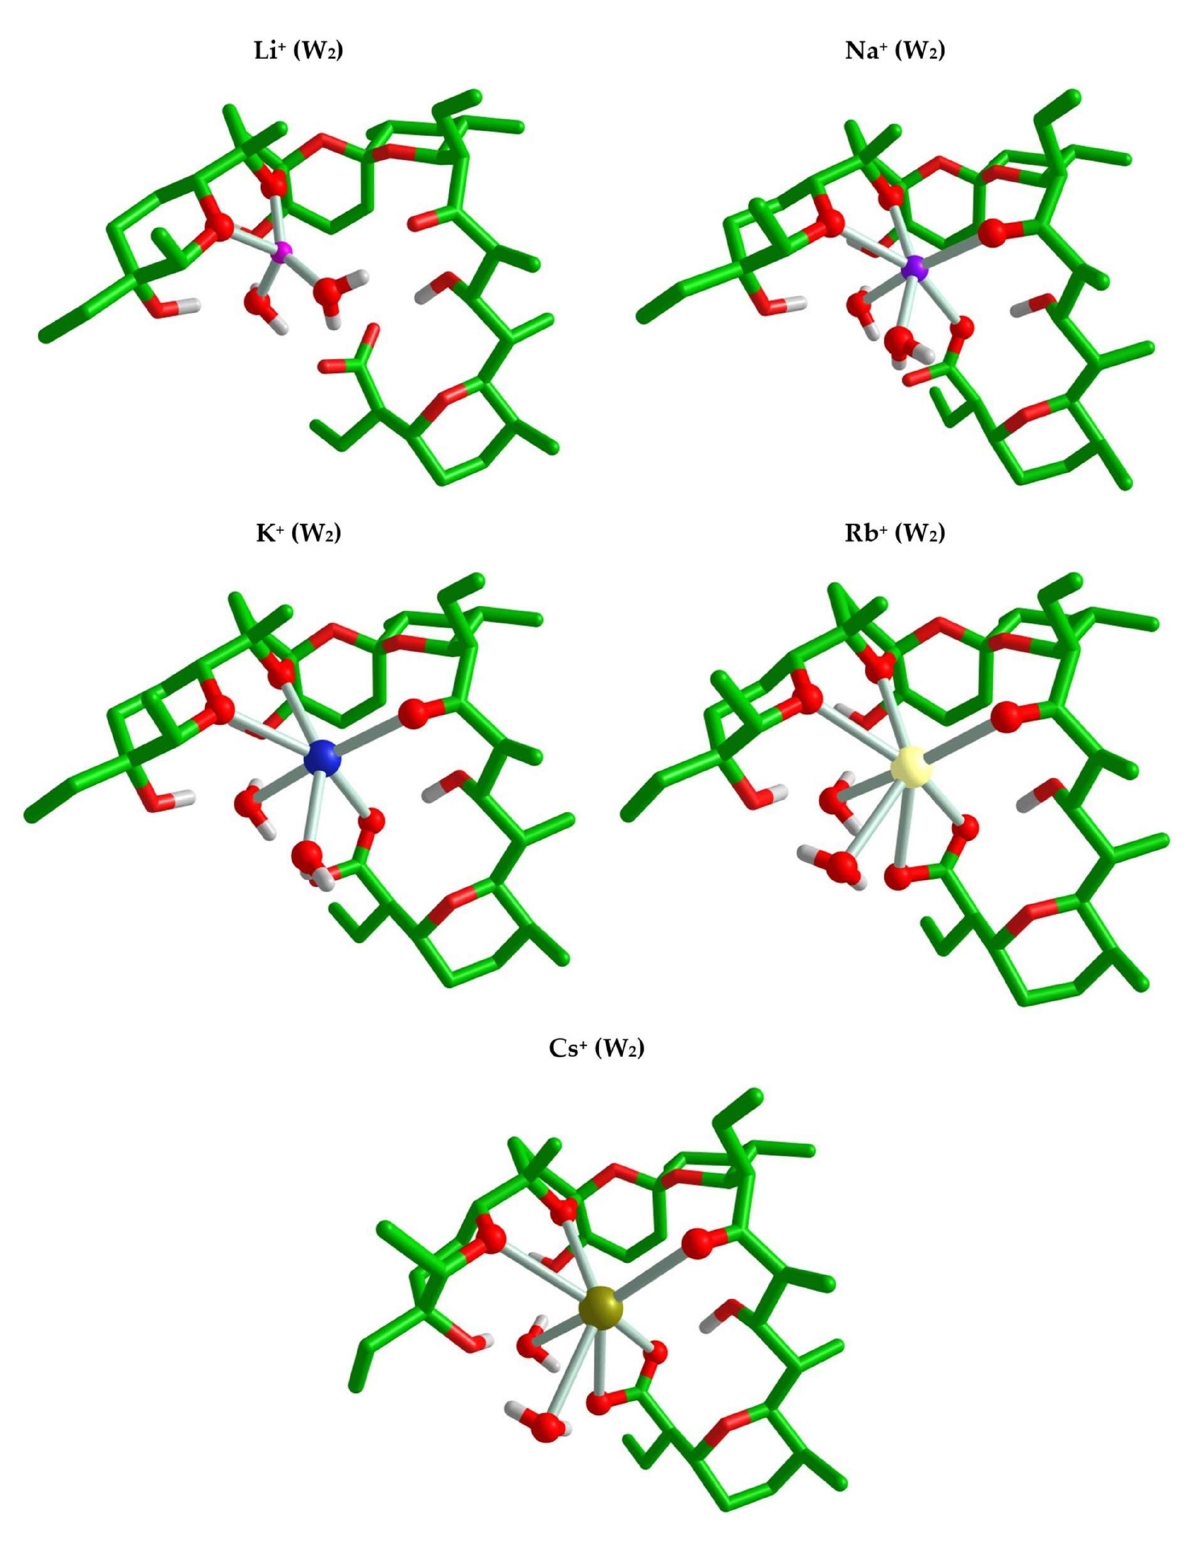
Figure 3. B3LYP/6-31+G(d,p) fully optimized structures of salinomycin complexes with Li + , Na + , K + , Rb + , and Cs + cations, containing two (W 2 ) water molecules. Color scheme: C—green, O—red, H—light grey, Li—magenta, Na—purple, K—blue, Rb—yellow, Cs—deep olive (carbon hydrogens are omitted for